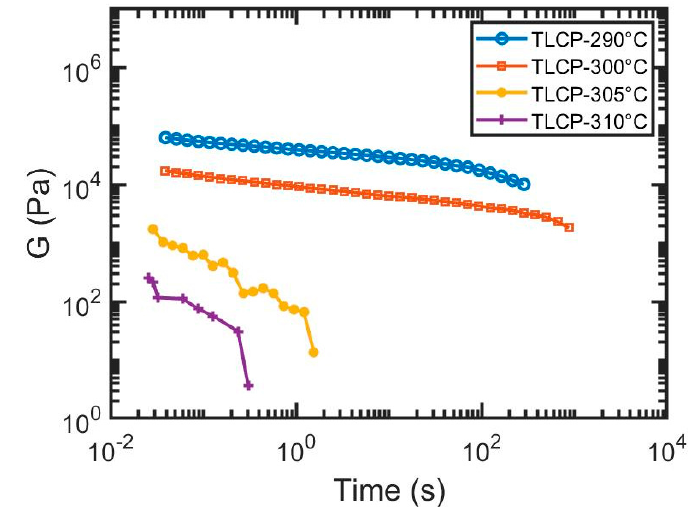
Figure 1. Stress relaxation of pure TLCP following a step shear strain at different test temperatures.